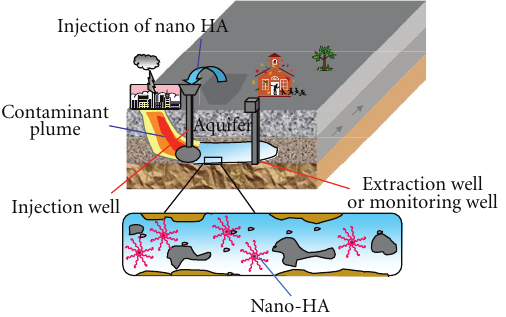
Figure 1: Schematic diagram of in situ groundwater remediation by injection of